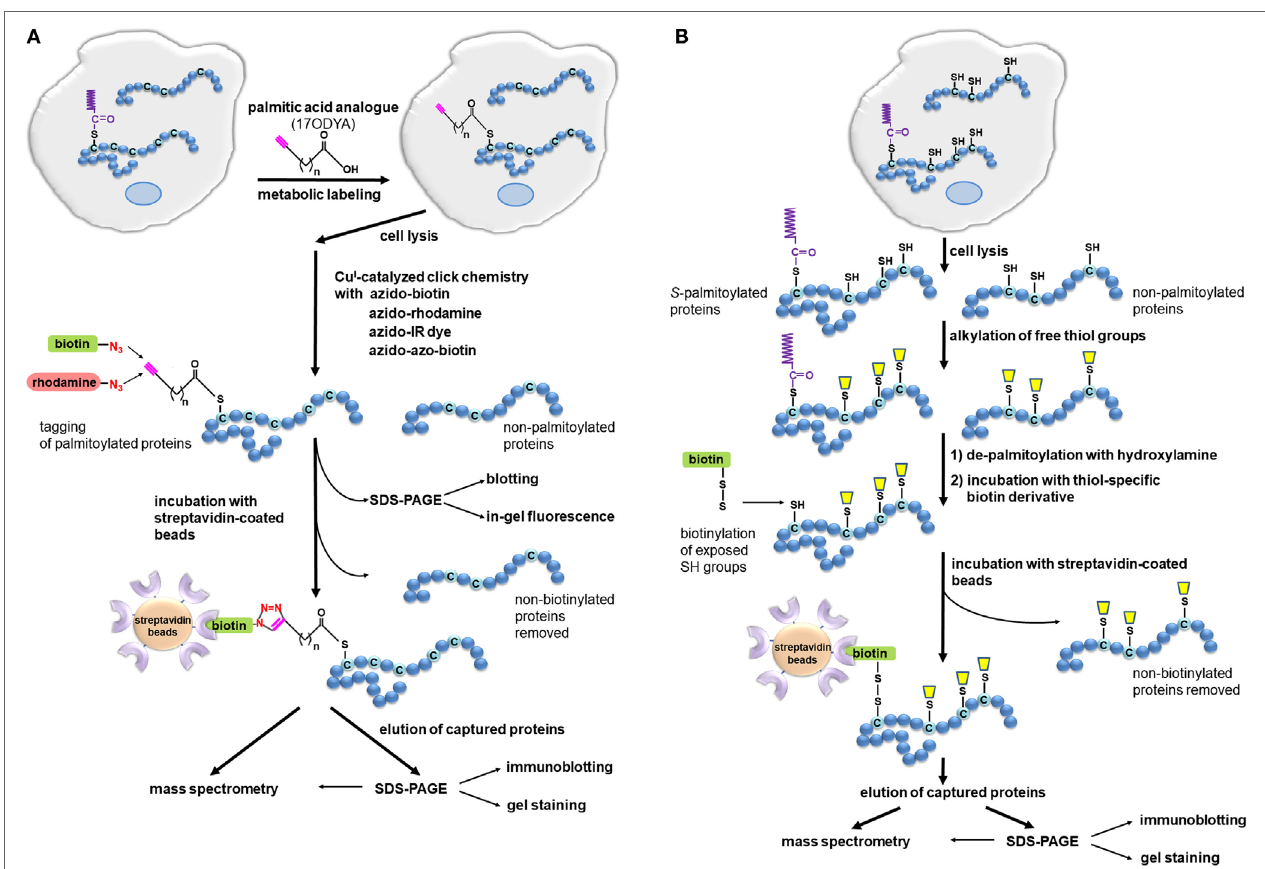
FigURe 2 | Detection of S -palmitoylated proteins using click chemistry and acyl-biotin exchange (ABE). (a) Click chemistry-based method. Cells are metabolically labeled with an alkyne-functionalized palmitic acid analog, such as 17-octadecynoic acid (17ODYA), and after cell lysis, the click reaction is conducted with azido-tagged biotin or fluorescent probes allowing enrichment and detection of labeled proteins in various ways. Biotinylated proteins can be bound on a streptavidin resin and then released using, e.g., high concentrations of urea and SDS (108). When a cleavable derivative of biotin, azido-azo-biotin, is used the labeled proteins are eluted from streptavidin beads with sodium dithionite, which cleaves the diazobenzene moiety in the linker arm of azido-azo-biotin, and analyzed by mass spectrometry or immunoblotting (109). (B) ABE method. Cells or tissues are lysed, free thiol groups of proteins are blocked by alkylation, and palmitoyl moieties are released with hydroxylamine. The newly exposed protein thiol groups are subjected to labeling with biotin-HPDP allowing selective binding, elution, and analysis of the originally S -palmitoylated proteins. The proteins can also be captured without biotinylation through a direct interaction of their thiol residues with a thiol-reactive resin (acyl-RAC